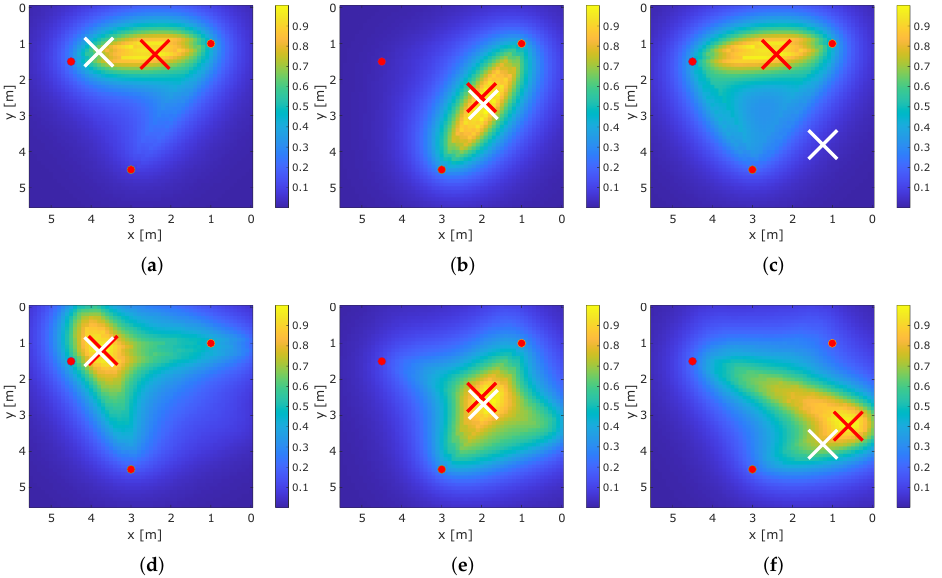
Figure 11. Exemplary results for RTI and MA-RTI. ( a ) RTI at position 4. ( b ) RTI at position 12. ( c ) RTI at position 18. ( d ) MA-RTI at position 4. ( e ) MA-RTI at position 12. ( f ) MA-RTI at position 18.